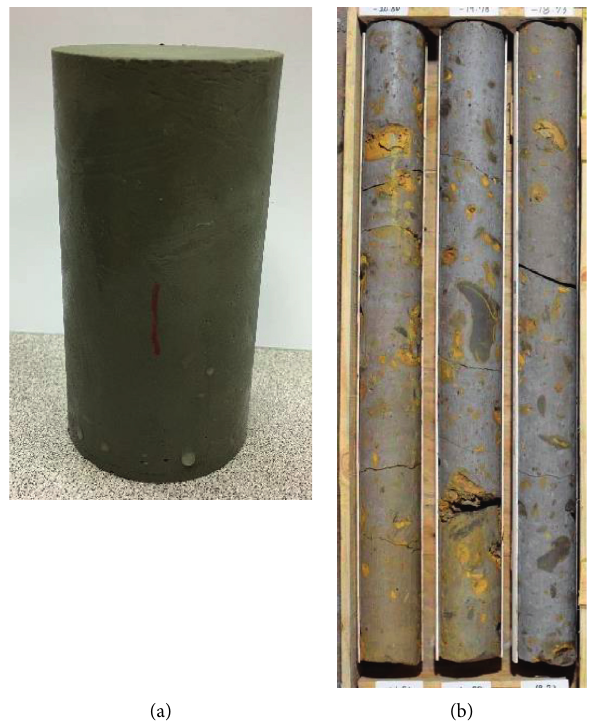
Figure 5: (a) A sample prepared in laboratory and (b) cored samples from a real project.